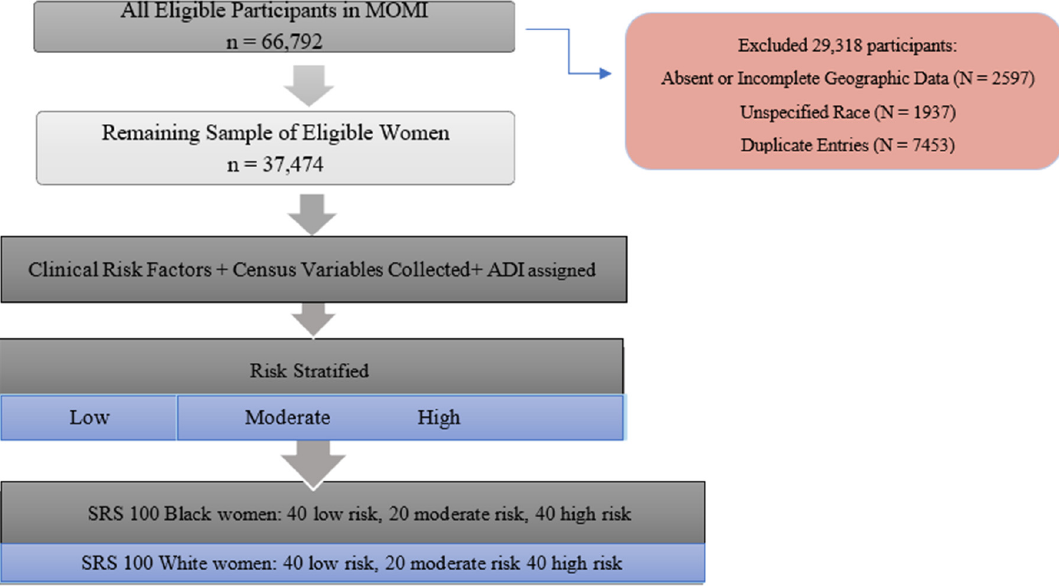
Figure 1. Sample Selection Process for Enrollment.